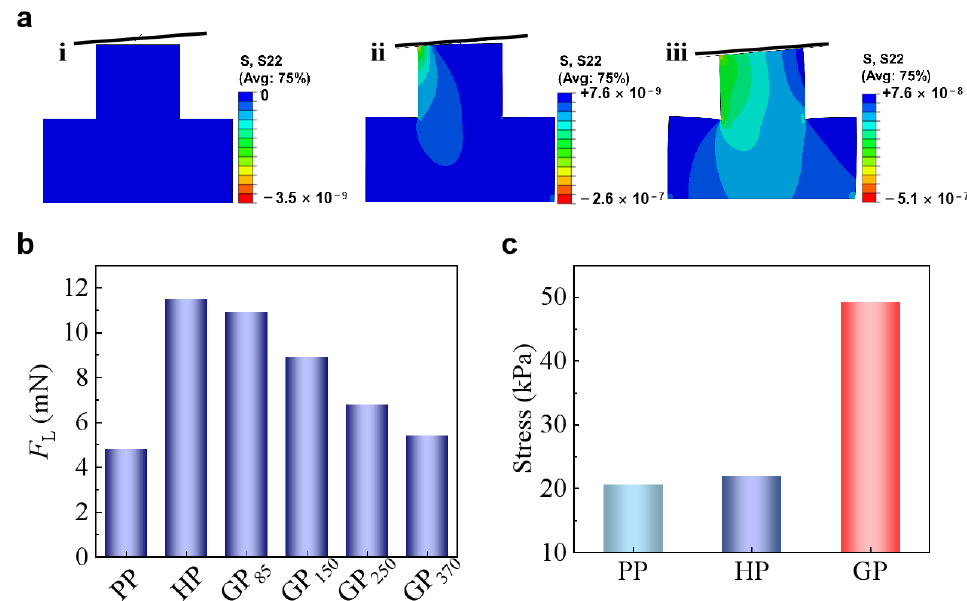
Figure 4. ( a ) Schematic diagrams of the three states of a tilted surface and the micropillar: i. before contact, ii. during contact, and iii. full contact. ( b ) F L needed to form full contact with surfaces with tilting angles of 3°. ( c ) Simulated stress at the central separating interface of PP, HP, and GP.